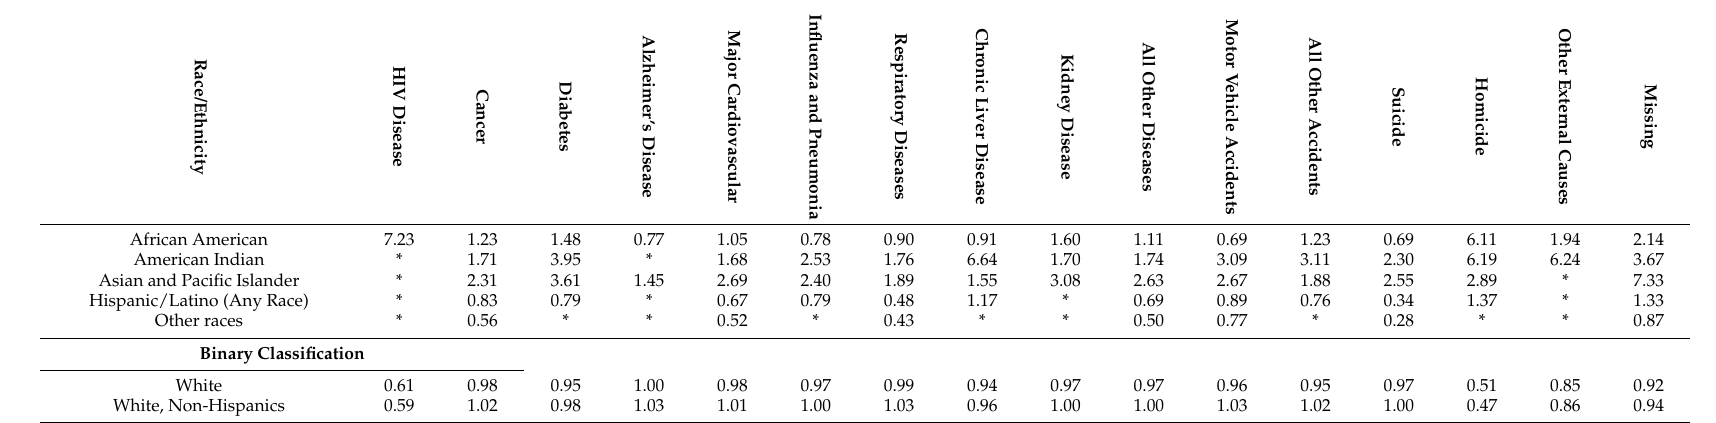
Table A1. Disparity ratio for age-adjusted mortality rate by cause of death and race/ethnicity in Minnesota, 2011–2015.